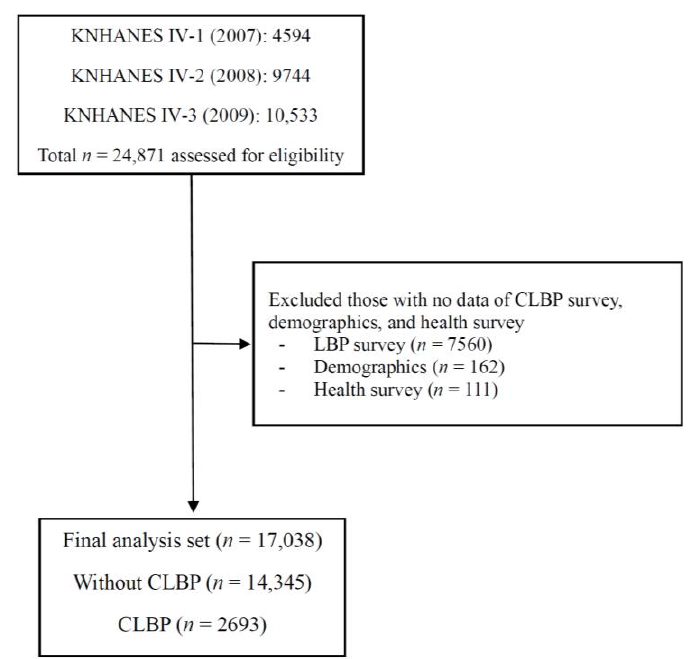
Figure 1. Flow diagram of the inclusion and exclusion of participants from the 2007, 2008 and 2009 Korea National Health and Nutrition Examination Surveys (KNHANES IV-1, IV-2 and IV-3). CLBP, chronic low back pain.